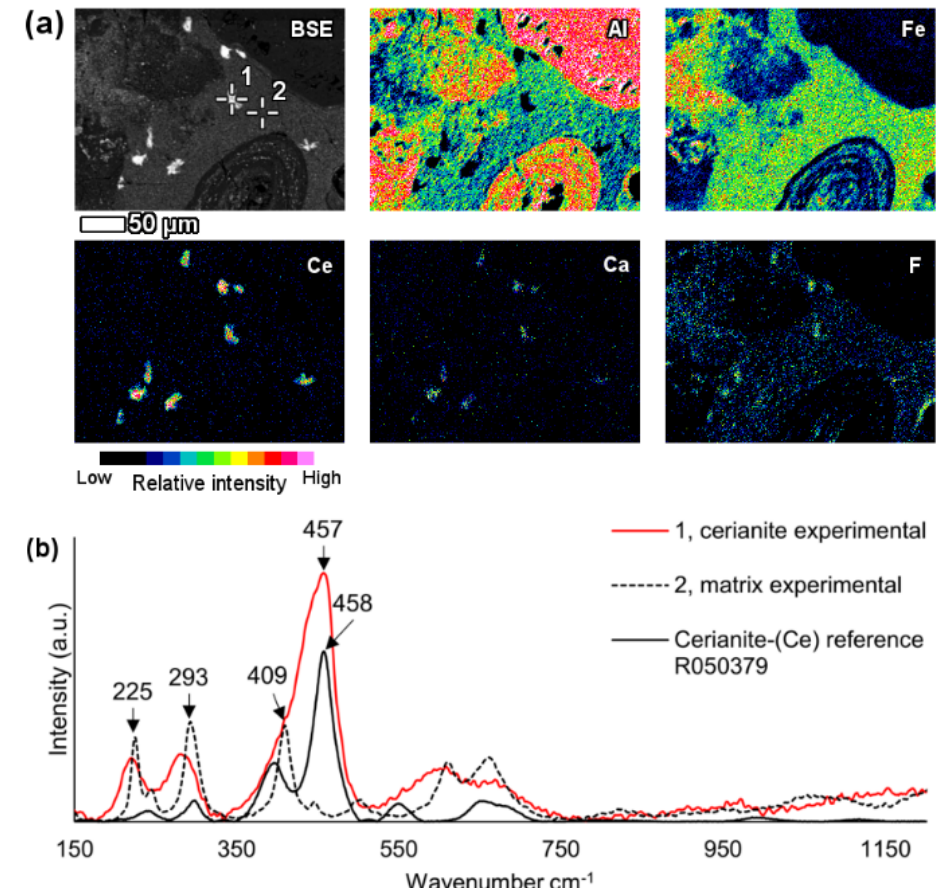
Figure 1. Cerianite rich area in in Parnassos-Ghiona bauxite shown on ( a ) backscattered electron (BSE) image with respective EDS elemental maps, and ( b ) Raman spectra of cerianite and its surrounding matrix compared to reference Raman spectrum obtained from RRUFF database [61], with permission from RRUFF™. Raman spectrum collected with a 532-nm wavelength laser.